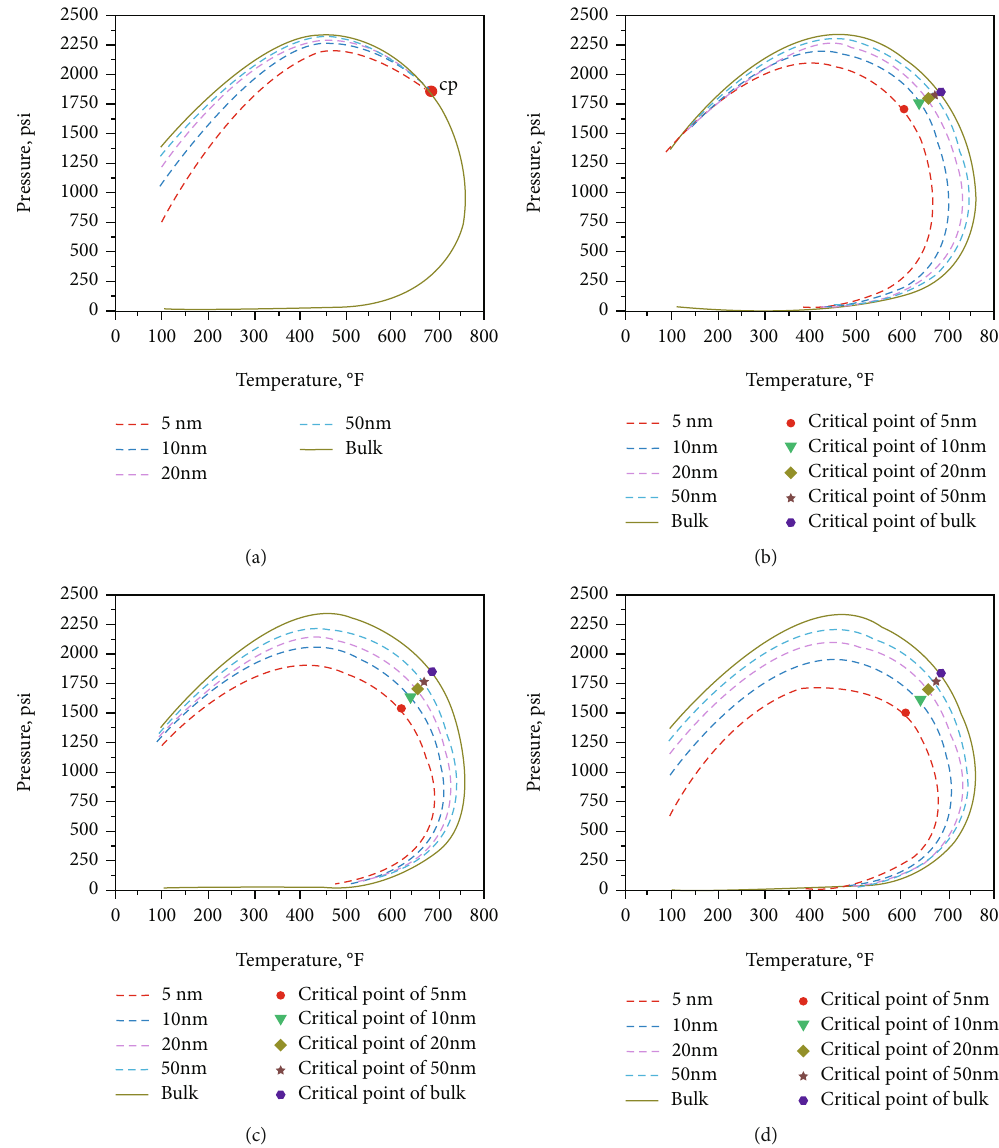
Figure 4: P-T phase envelope for Bakken tight oil reservoir at various pore sizes considering (a) capillary pressure, (b) fl uid-wall interaction, (c) adsorption e ff ect, and (d) nanopore con fi nement e ff